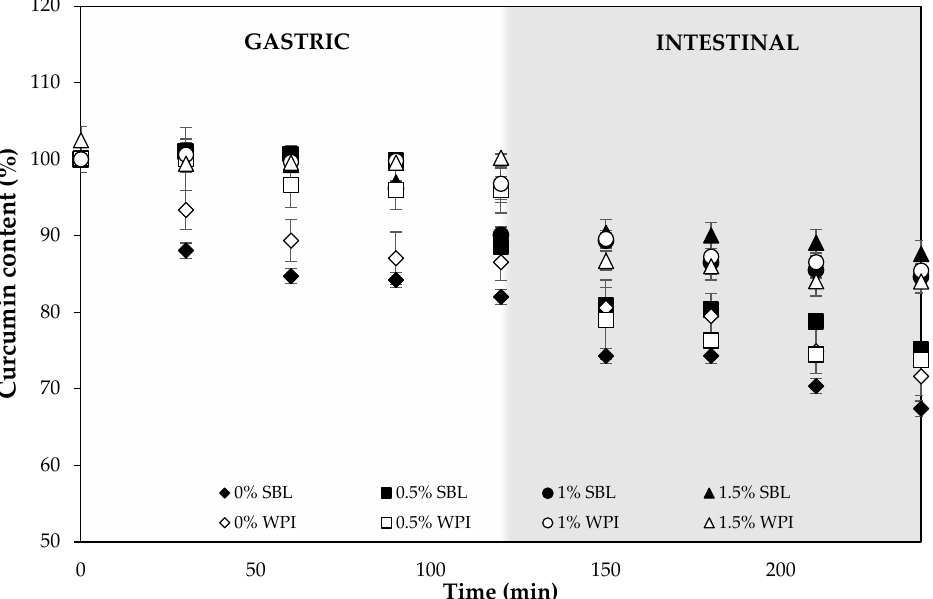
Figure 8. Curcumin content of nanoemulsions stabilized with lecithin (SBL) or whey protein isolate (WPI) and different sodium alginate concentrations (0, 0.5, 1 and 1.5%) during the gastrointestinal in vitro digestion.